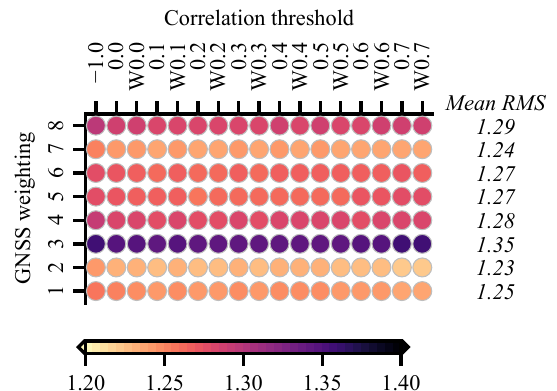
Figure 7. RMS (mmyr − 1 ) of differences between GNSS and ALT– TG VLM trends. The “W” indicates weighting by correlation. The “ − 1 . 0” indicates that no correlation threshold is set. The numbers of the y axis refer to the approaches used to combine the GNSS trends as described in Sect. 2.1.2. Figure 8. Histogram of GNSS and ALT–TG trend differences. In blue are the results without any correlation threshold and in red with a correlation threshold of 0.7 and correlation